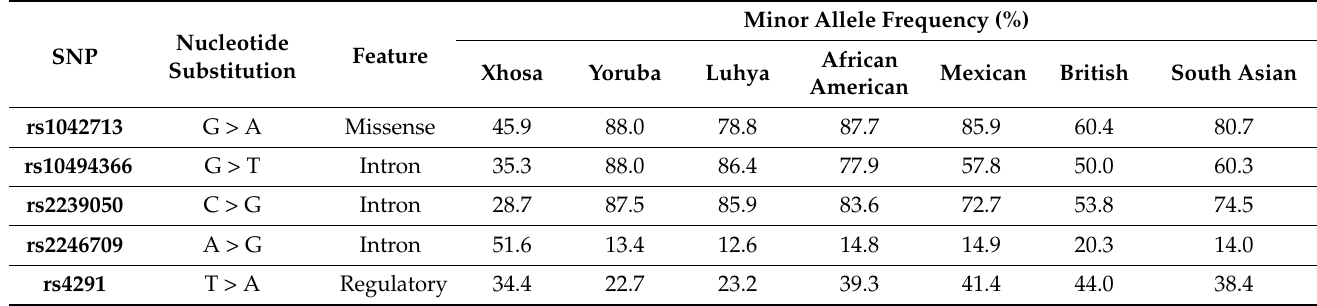
Table 4. Minor allele frequency distribution across different population groups.